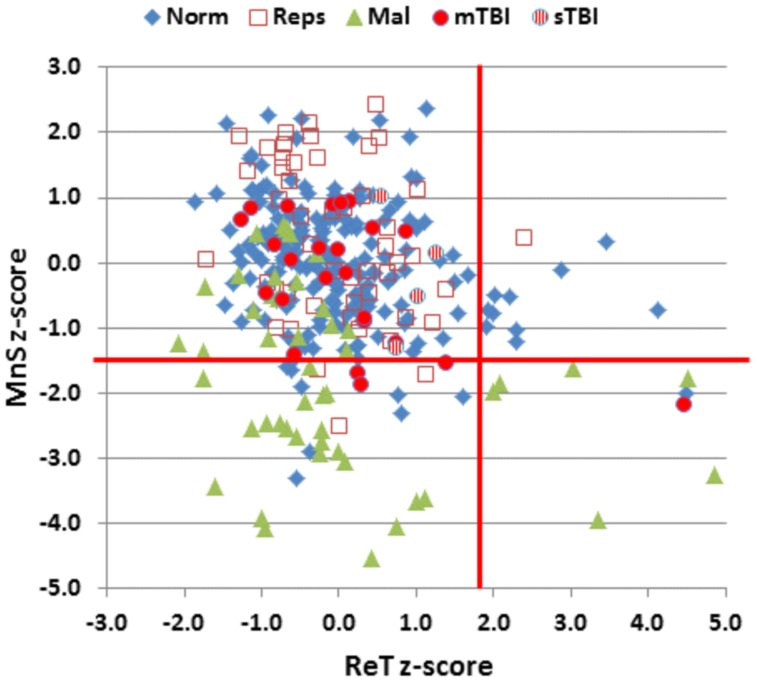
Mean span (MnS) and log-transformed ReT z-scores. The z-scores were corrected for the contributions of age and computer-use using multiple regression values from the normative data. Vertical and horizontal red lines show p < 0.05 abnormality thresholds. See Figure 2 for group membership specifications.